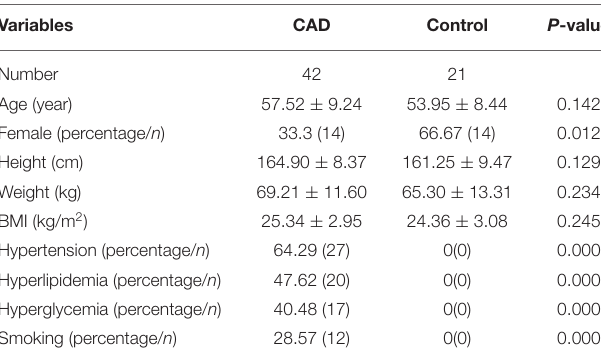
TABLE 1 | Base information and major cardiovascular risk factors in the two